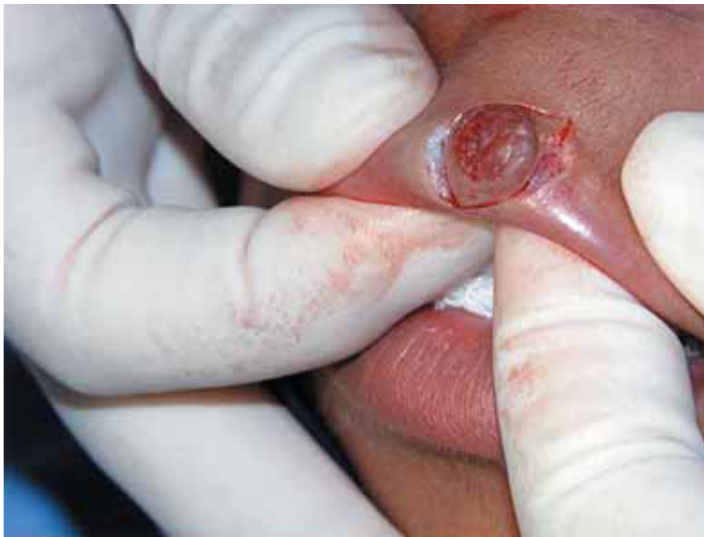
Figure 2- Excisional biopsy to remove the